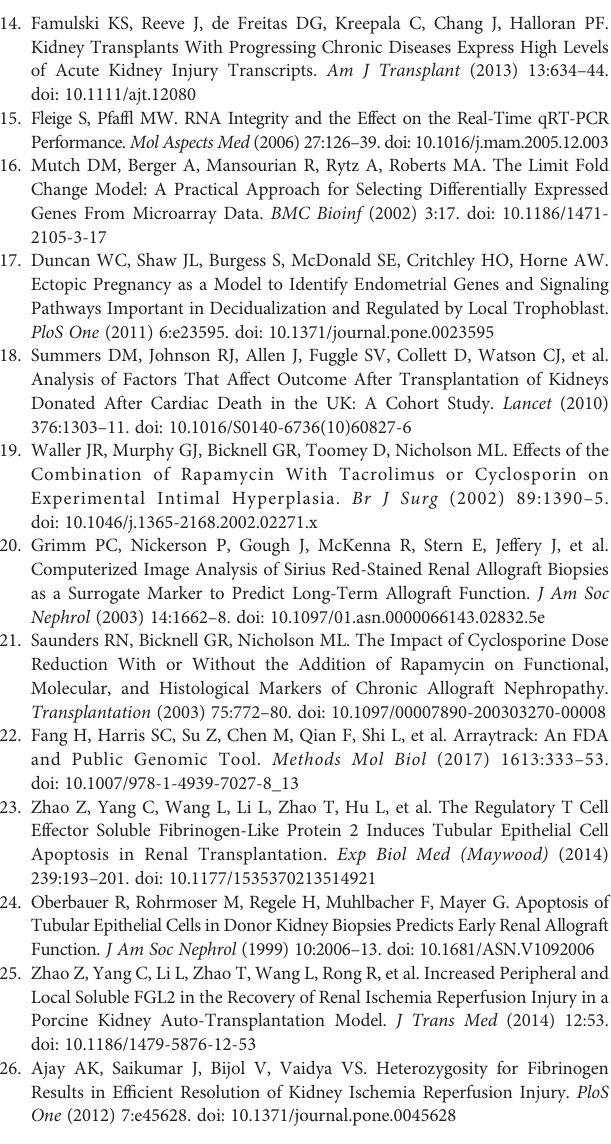
correlated with both SCr and SR staining for further qPCR detection to identify biomarkers. SCr, serum creatinine; SR, Sirius red staining. Supplementary Table 3 | DEGs revealed by microarray analysis and associated with kidney injury or allograft rejection from this study and previous publications. There were some commonly DEGs (underline) between